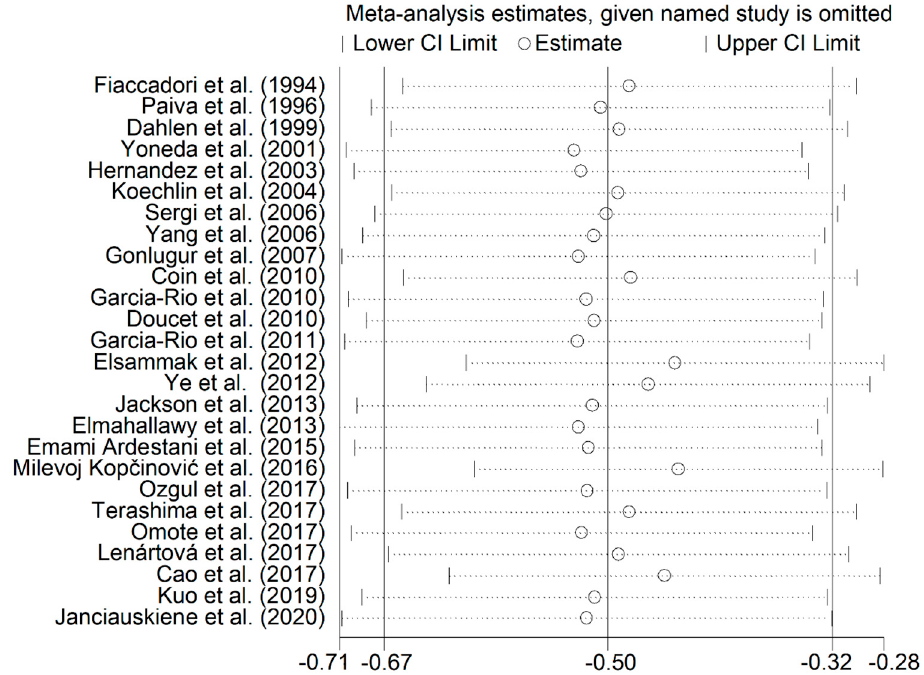
Figure 3. Sensitivity analysis of the association between albumin and COPD. The influence of individual studies on the overall standardized mean difference (SMD) is shown. The middle vertical axis indicates the overall SMD, and the two vertical axes indicate the 95% confidence intervals (CI). Hollow circles represent the pooled SMD when the remaining study is omitted from the meta-analysis. Two ends of each broken line represent 95% CI.